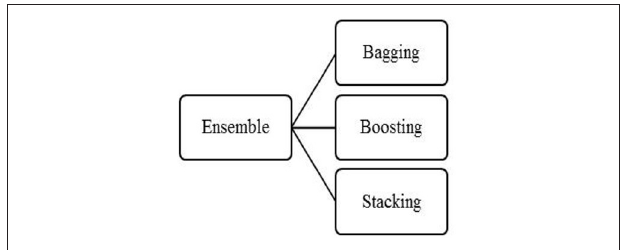
FIGURE 1 | Ensemble techniques.